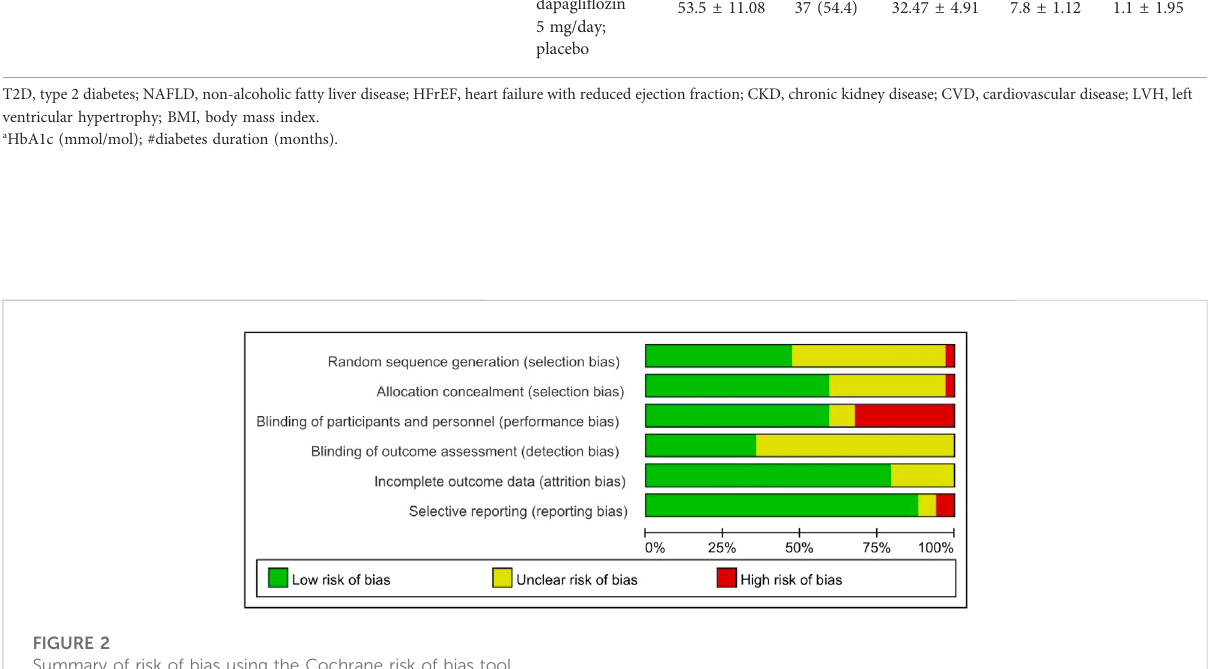
Summary of risk of bias using the Cochrane risk of bias